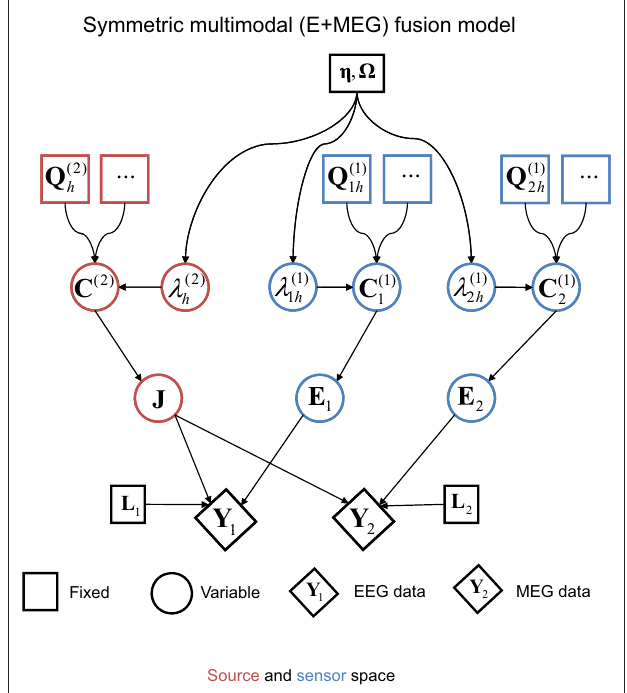
Figure 4 | The extension of the generative model in Figure 1 to the fusion of eeg and Meg data, i.e., j = 1–2 modalities ( Y was the one used to produce the results in Figure 5 ; i.e., with one minimum norm source prior (